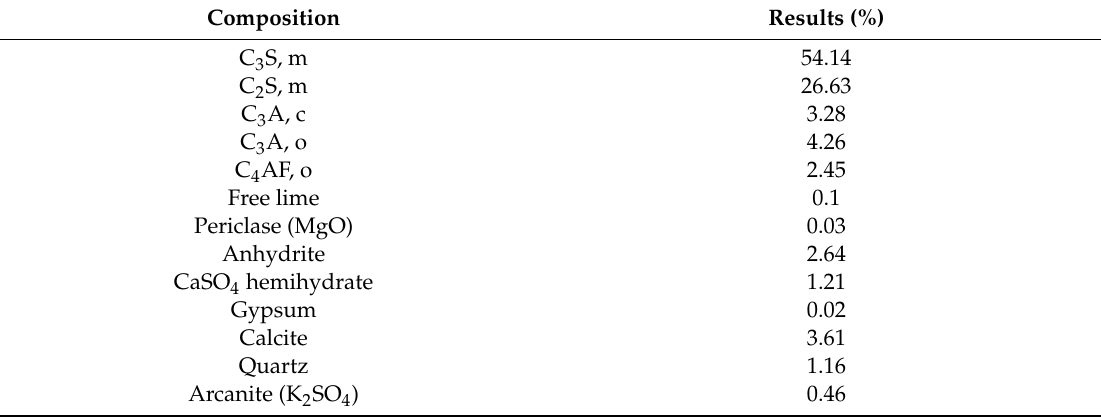
Table 1. Chemical and mineral compositions of CEM I 52.5 cement, weight fraction, %.